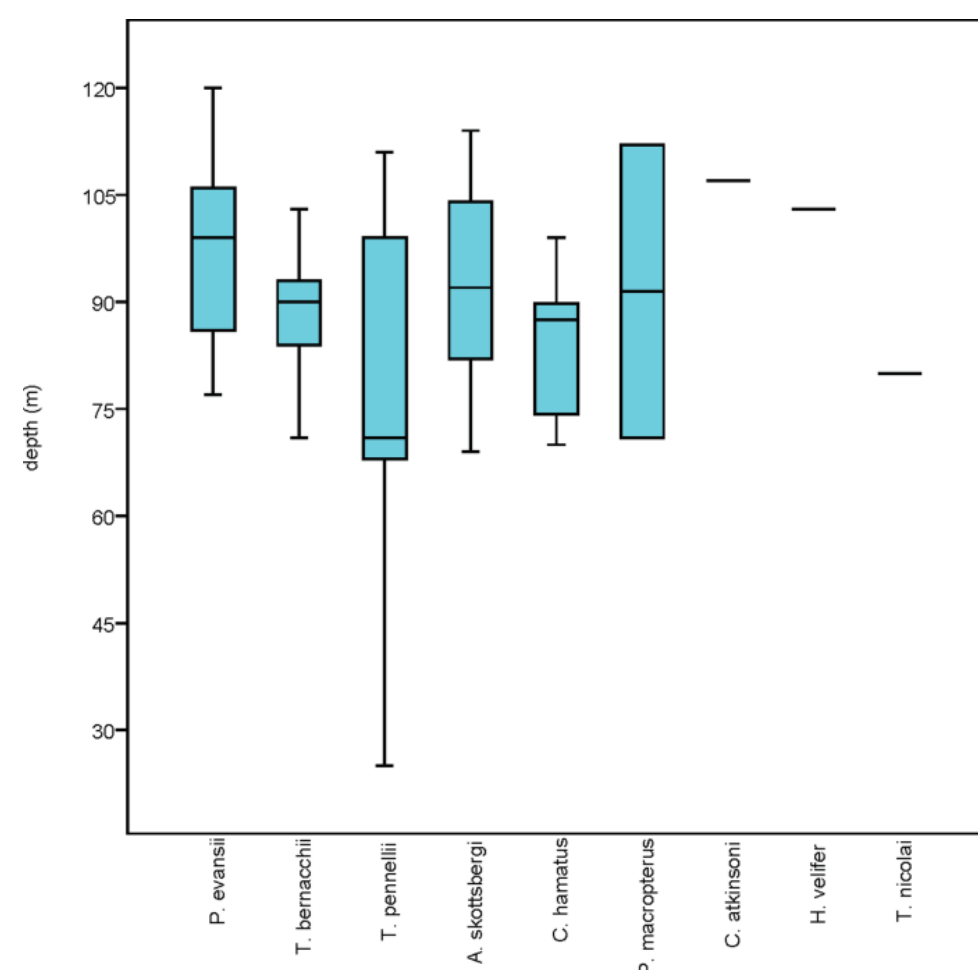
Figure 4. Box plot showing median, 25–75 percentiles, and maximum-minimum depth distribution of species along the transect Adélie Cove .